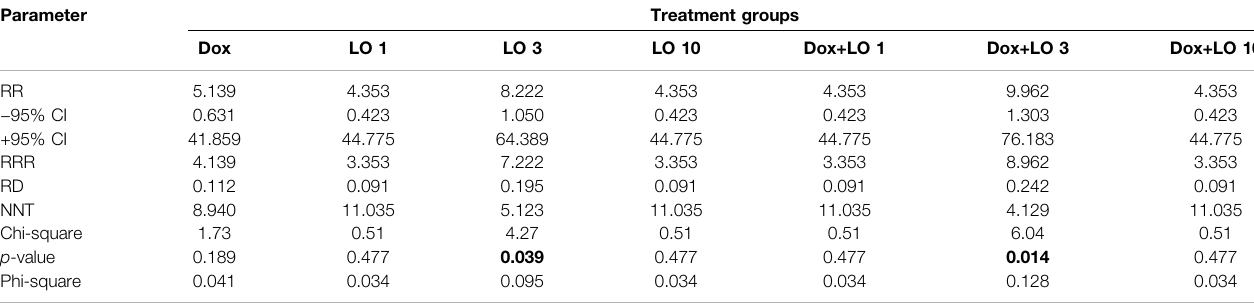
The values of p < 0.05 are highlighted in bold, which indicates statistically signi fi cant differences between the experimental and control groups. RR, Relative risk; RRR, Relative risk reduction; RD, Risk difference; NNT, Number needed to treat; Chi-square, Yates corrected Chi-square; - − 95% CI, Lower limit (95% con fi dence interval); +95% CI, Upper limit (95% con fi dence